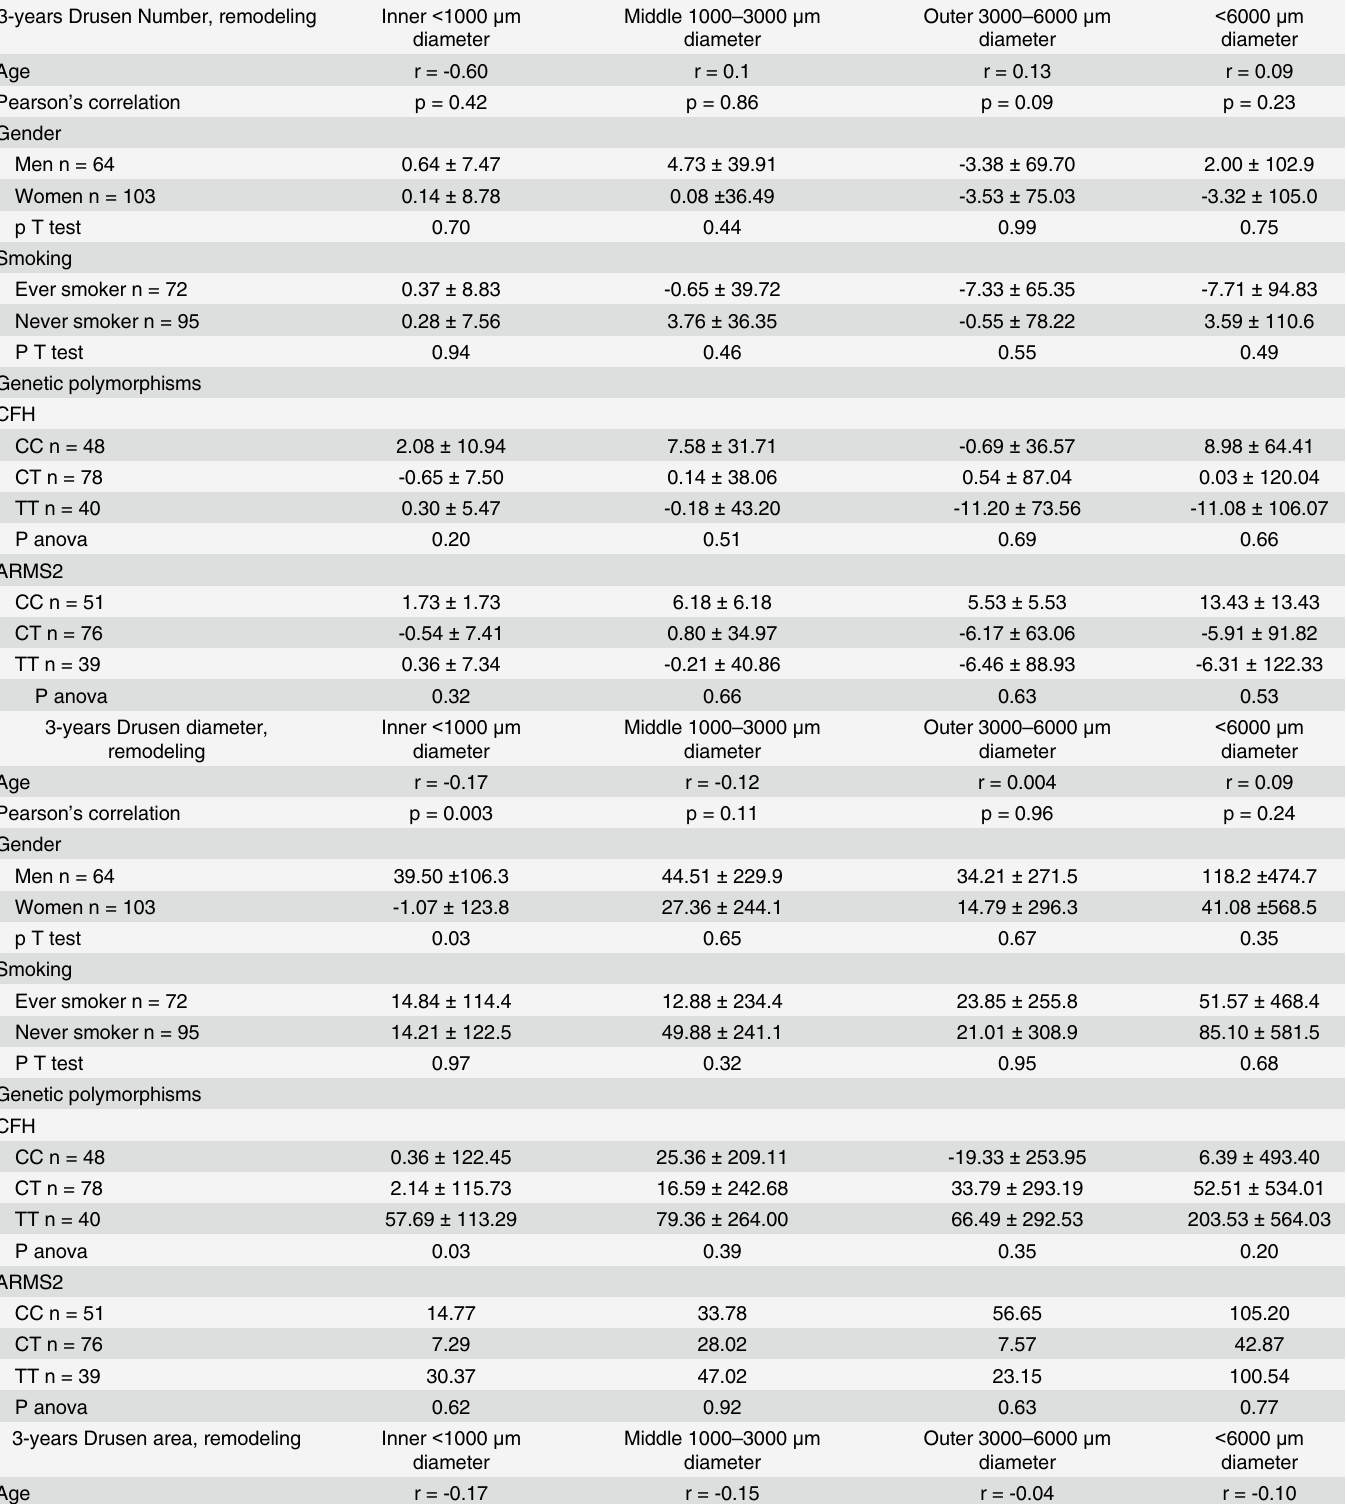
Table 4. Associations of 3-year drusen number, diameter and area remodeling with socio-demographic and genetics characteristics at